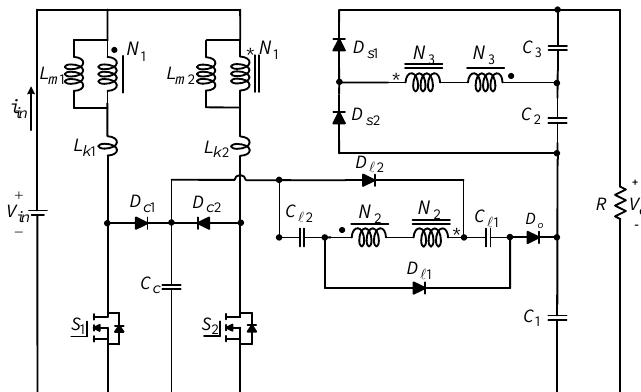
Figure 2. Equivalent circuit of the proposed converter.